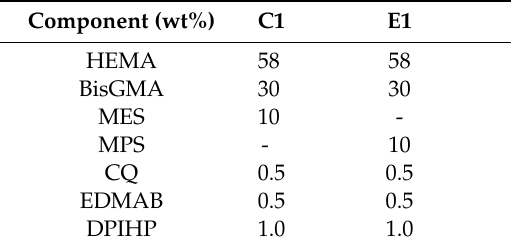
Table 1. Composition of the control and experimental